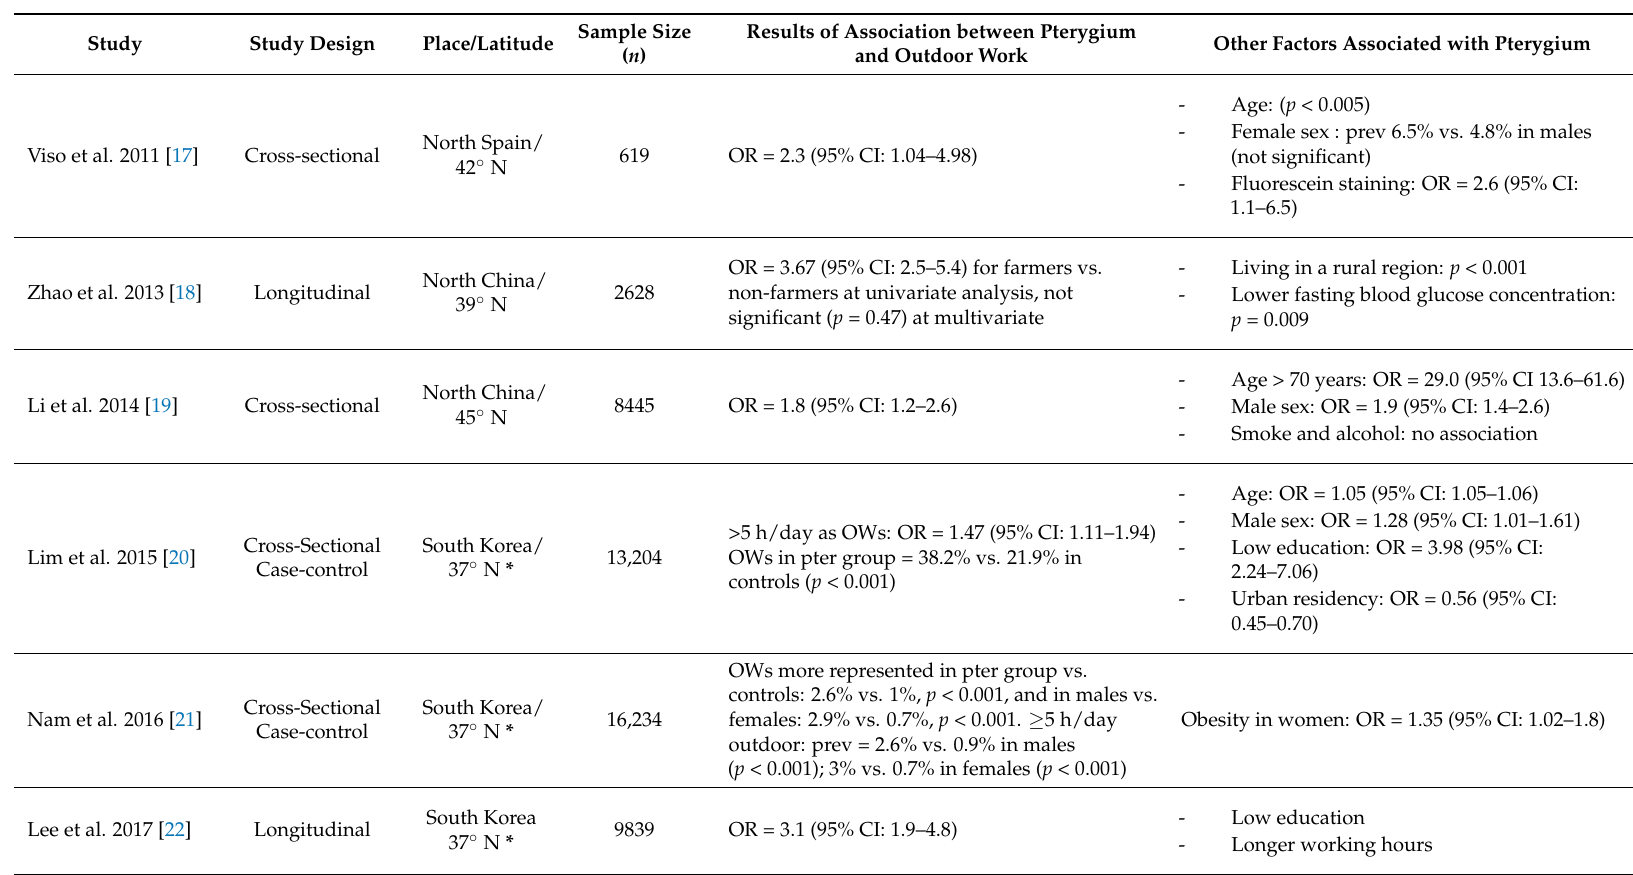
Table 2. Synthesis of the studies on occupational solar UV radiation exposure and pterygium included in the systematic review of scientific literature published in the period 2008–2017 performed in World areas at moderate risk considering the mean annual UV index